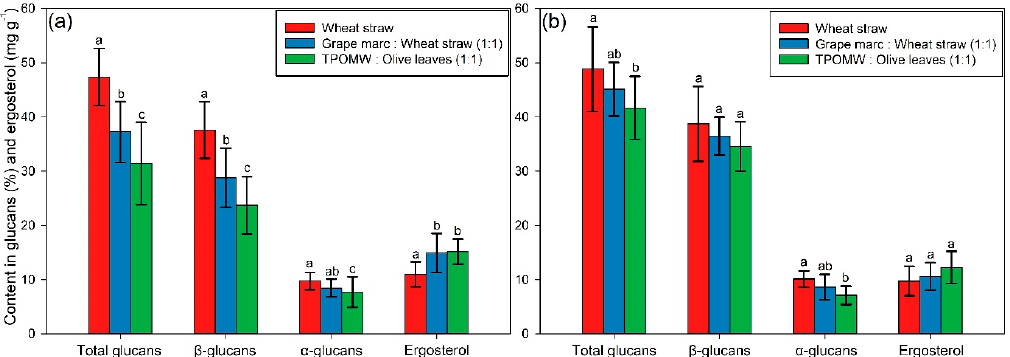
Figure 1. Mushroom contents in the total, α - and β -glucans (% dw), and ergosterol (mg g − 1 dw) for ( a ) Pleurotus ostreatus and ( b ) P. eryngii cultivated in three substrates, i.e., wheat straw (control; WS), grape marc plus wheat straw (1:1 w/w; GM) and two-phase olive mill waste (TPOMW) plus olive leaves (1:1 w/w; OL). Error bars represent standard deviation among the strains of each species. Lack of letters in common indicates statistically significant differences (Duncan’s t-Test, p < 0.05) in comparisons of bioactive compounds content between different substrates for each species examined.